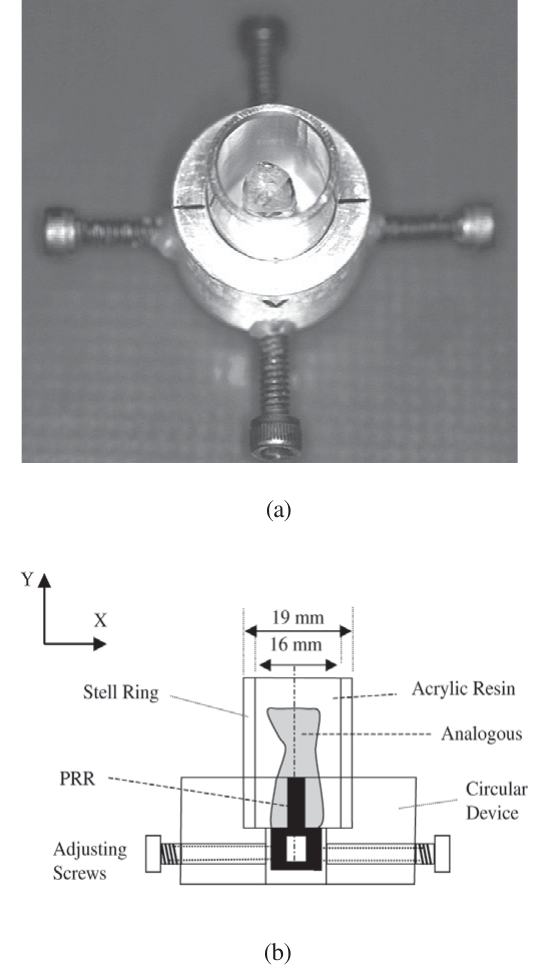
Figure 5. Schematic view of the device used to centralize the analo- gous; a) 3-D view of the device; b) cross section view of the vice.